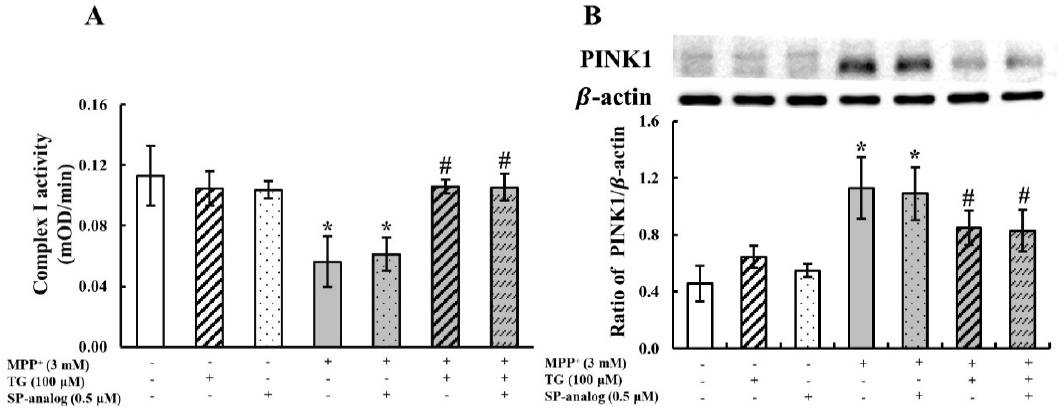
Figure 5. The protective effects of teaghrelin (TG) on 1-methyl-4-phenylpyridinium (MPP + )-induced mitochondrial dysfunction was not blocked by substance P (SP-analog). SH-SY5Y cells were treated with TG or SP analog in the presence or absence of MPP + for 24 h. After various treatments, mitochondrial complex I activity was measured at 450 nm using a microplate reader ( A ). Cells were harvested and analyzed through Western blotting using antibodies against phosphatase and tensin homologue-induced kinase 1 (PINK1) ( B ). The expression of β -actin was used as the internal control. The results were analyzed using one-way analysis of variance. Values are presented as the mean ± standard deviation ( n = 3). * p < 0.05 compared with the control group, # p < 0.05 compared with MPP + alone. -: untreated with drugs or compounds, +: treated with drugs or compounds.